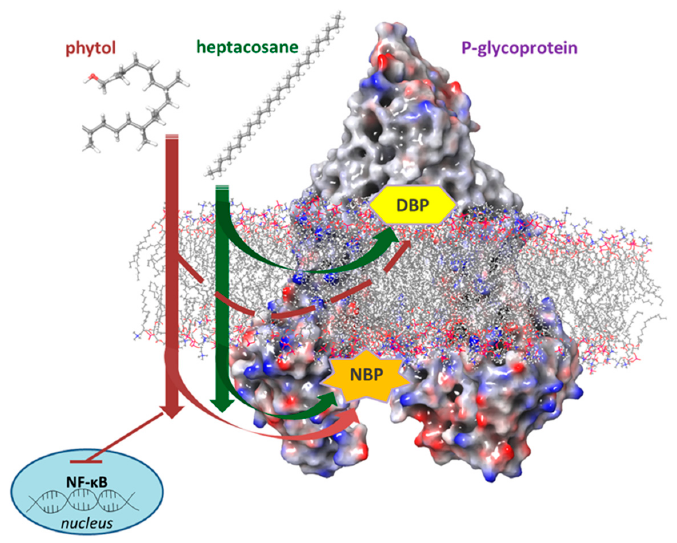
Figure 10. The potential mechanism of phytol and heptacosane on P-glycoprotein.